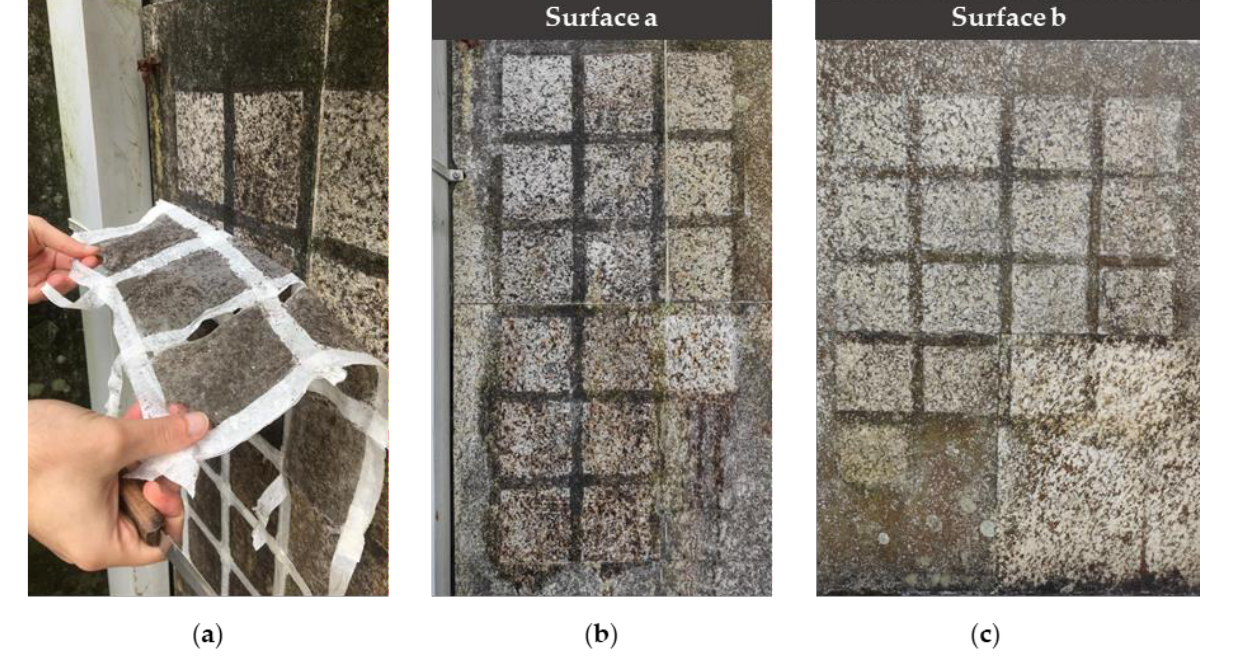
Figure 6. Appearance of the experimental surfaces after the cleaning procedures. ( a ) Peeling of the treatment that provided the employment of the hydrogel; ( b ) Surface a after the removal of the treatments (t 1 ) and ( c ) Surface b after the removal of the treatments (t 1